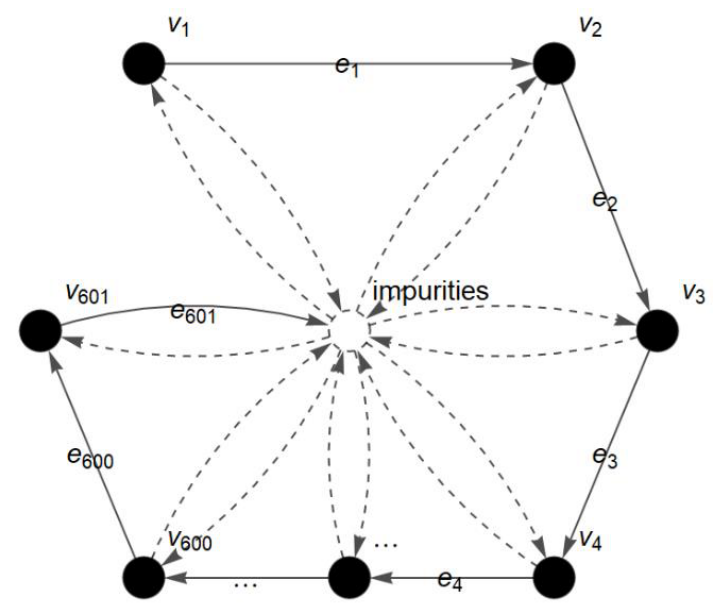
15 of 19 Figure 8. PCA score plot of Arabica and Robusta coffee beans. The PCA results by Briandet et al. [27] also showed distinct clusters of Arabica and Robusta coffee beans with respect to second and third component scores. However, their PCA method failed to determine their significant wavenumbers. According to Briandet et al. [27], Robusta coffee has higher content of caffeine and chlorogenic acid as compared to Arabica, and the bands that associated with caffeine and chlorogenic acid are in the range of 1750–1550 cm −1 and 1300–1150 cm −1 regions, respectively. Thus, the dominant wavenumber results obtained from c-FACS for Robusta at 1297–